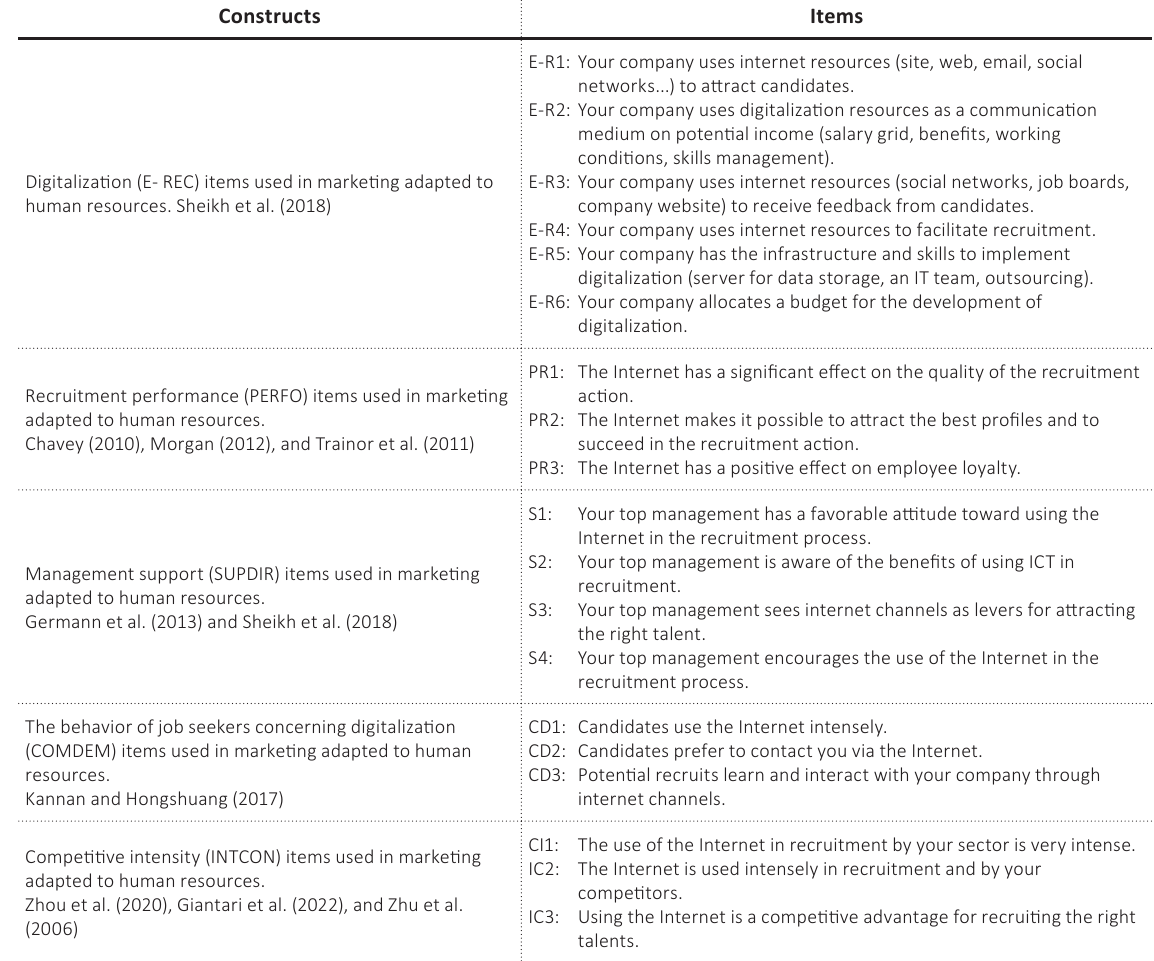
Table 1. Item definitions Constructs